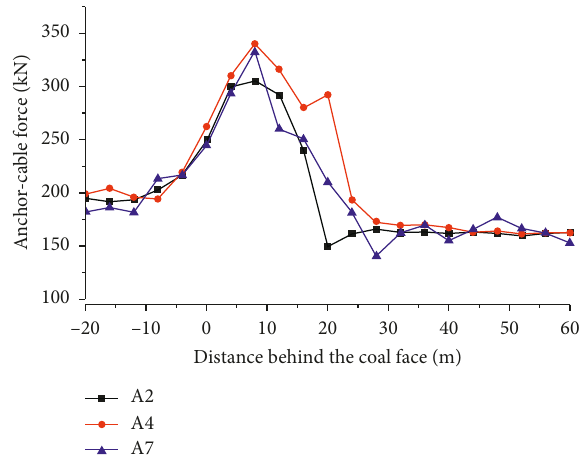
Figure 14: Monitoring curve of anchor-cable